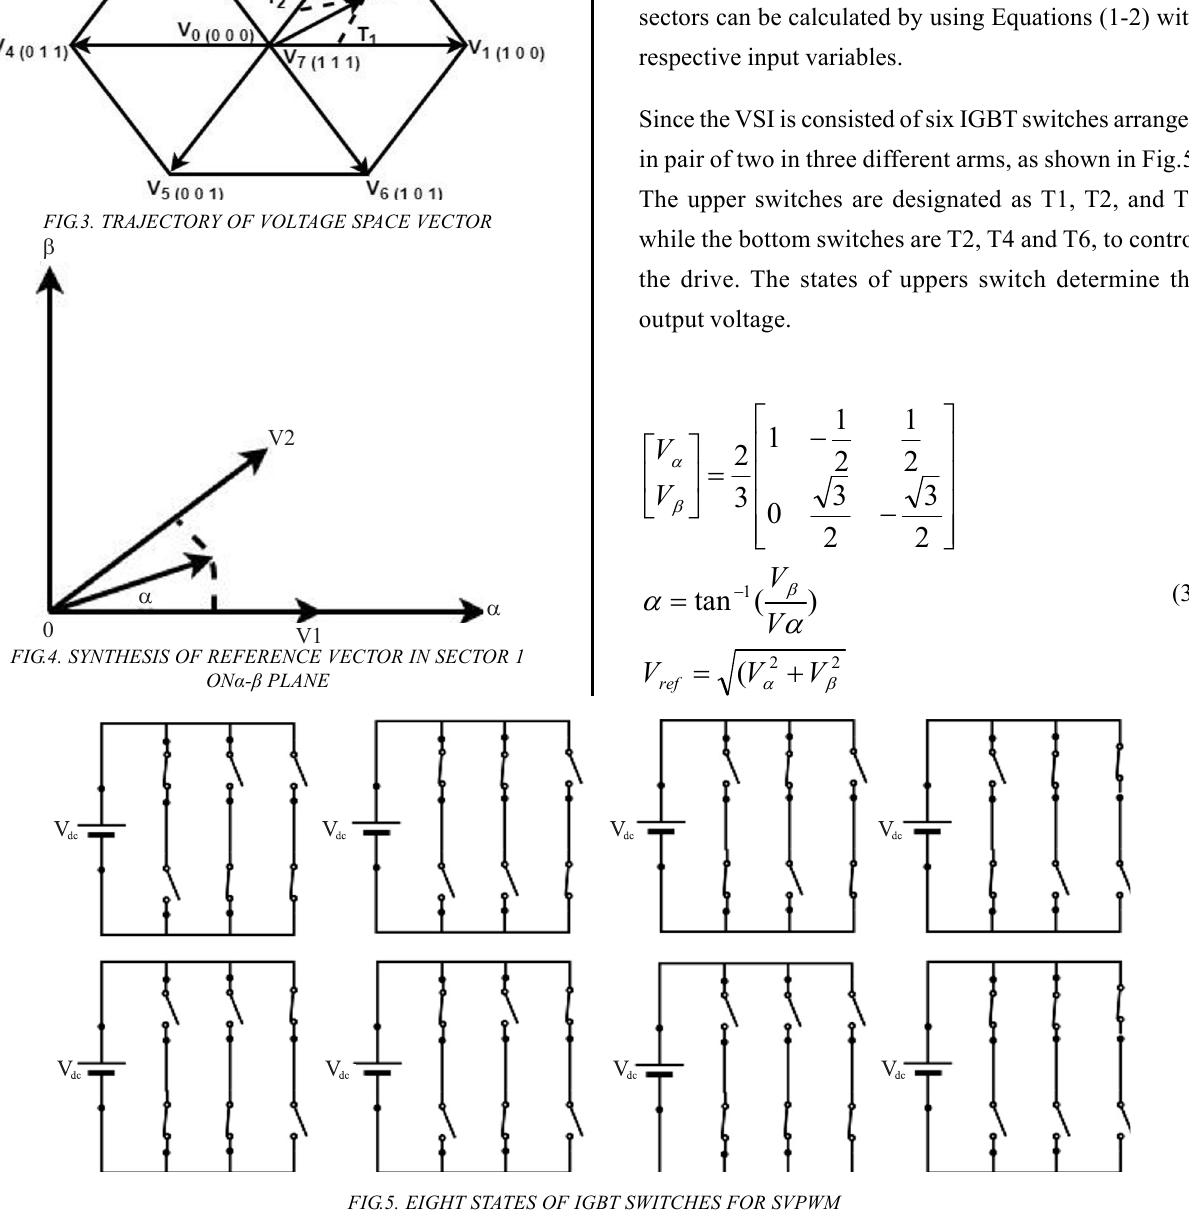
FIG.5. EIGHT STATES OF IGBT SWITCHES FOR